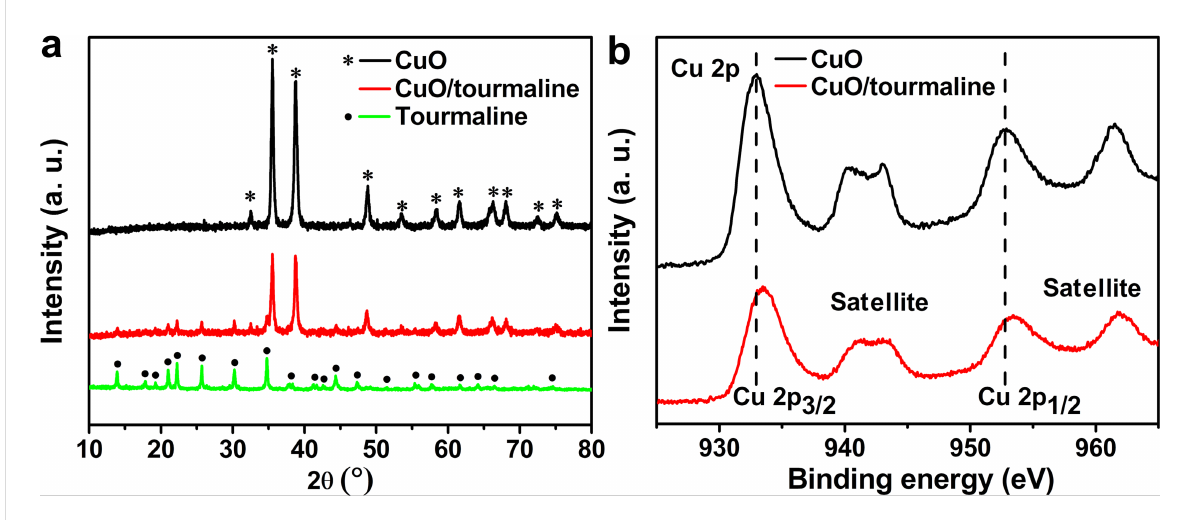
Figure 1: (a) XRD spectra of the CuO, tourmaline, and CuO/tourmaline composite. (b) High-resolution Cu 2p XPS spectra of the CuO and CuO/tour- maline